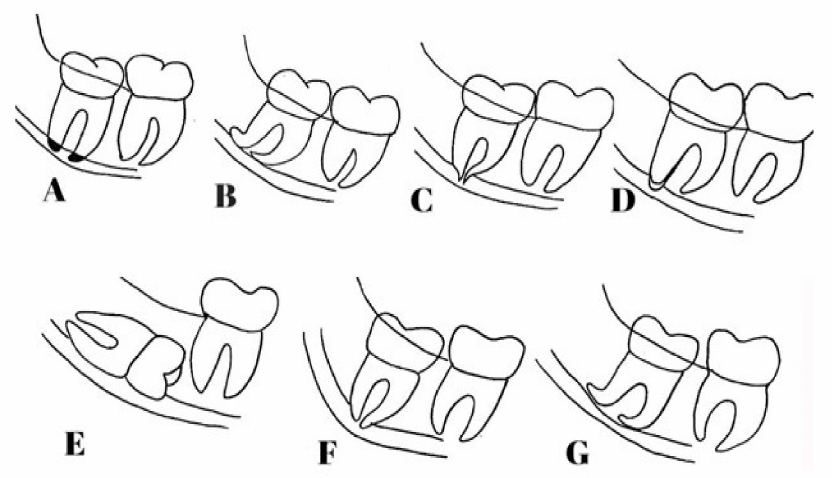
Figure 1. Seven radiographic signs for the contact of the IMTMs with the MC on panoramic images, based on the classification by Rood and Shehab: ( A ) root darkening, ( B ) root deflection, ( C ) root narrowing, ( D ) darkening and branching of the root, ( E ) interference with the white line, ( F ) MC diversion, and ( G ) MC